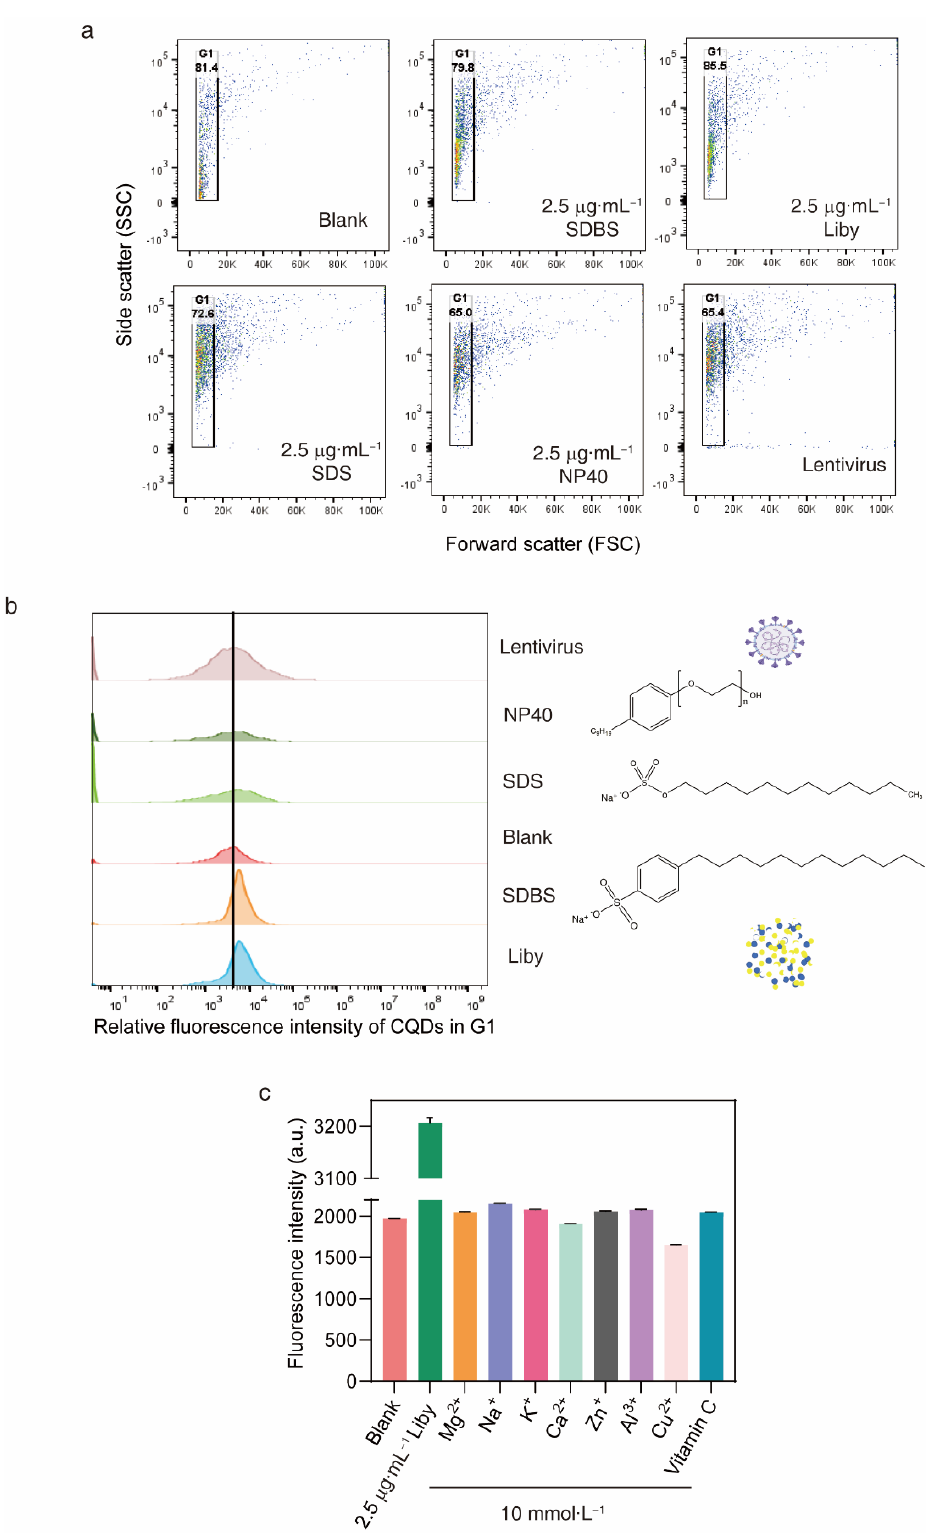
Figure 7. Laundry detergents enhance the fluorescence intensity of CQDs. ( a ) CQDs were assessed using FSC/SSC parameters. ( b ) Relative fluorescence intensity of CQDs in the G1 region quantified by flow cytometry with or without 2.5 μg·mL −1 SDBS, Liby, SDS, NP40 or 6.25 × 10 5 lentiviral particles. ( c ) Fluorescence intensity of CQD solutions measured in the presence of 10 mmol·L −1 Mg 2+ , Na + , K + , Ca 2+ , Zn + , Al 3+ , Cu 2+ , vitamin C and 2.5 μg·mL −1 Liby.